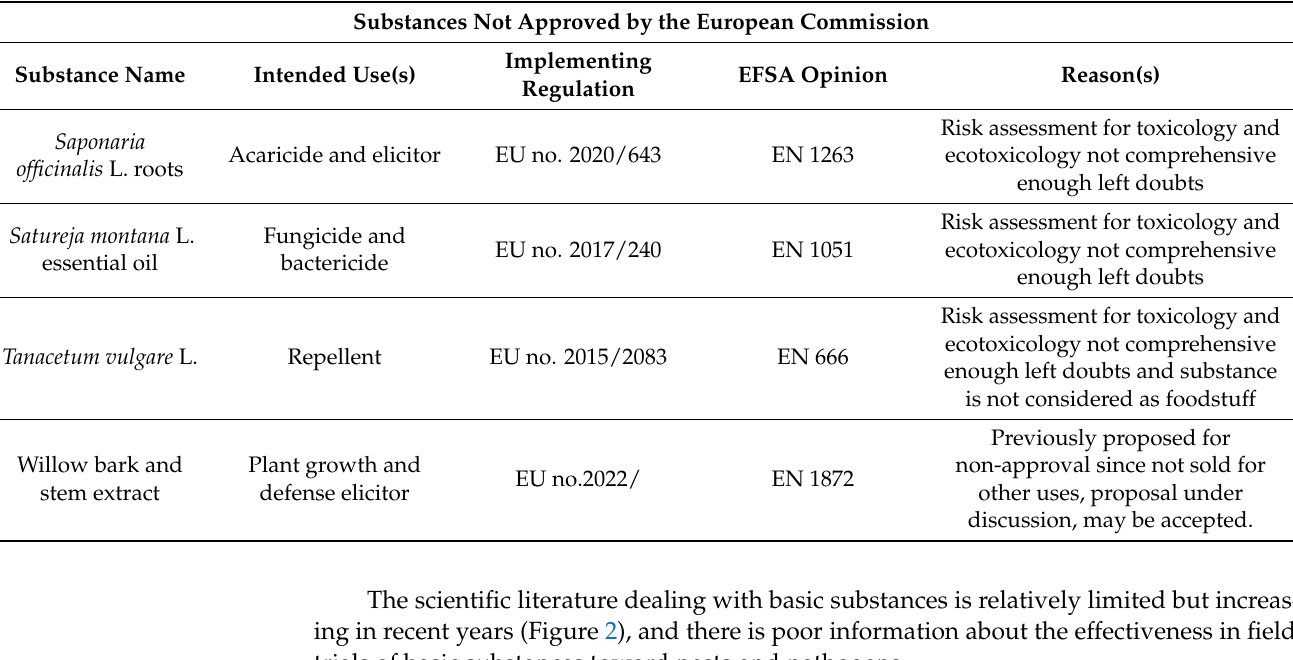
Table 5. Examples of requests from the retailer of the amount of the Maximum Residue Level (MRL) and Acute reference doses (ARfD).